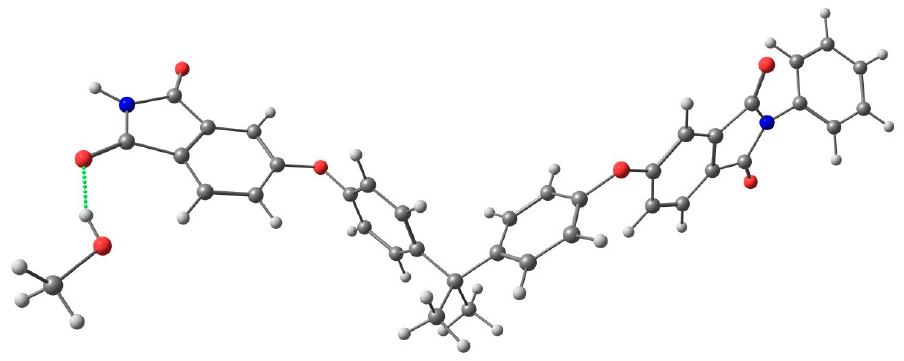
Figure 10. Scheme of coordination of methanol with PEI.